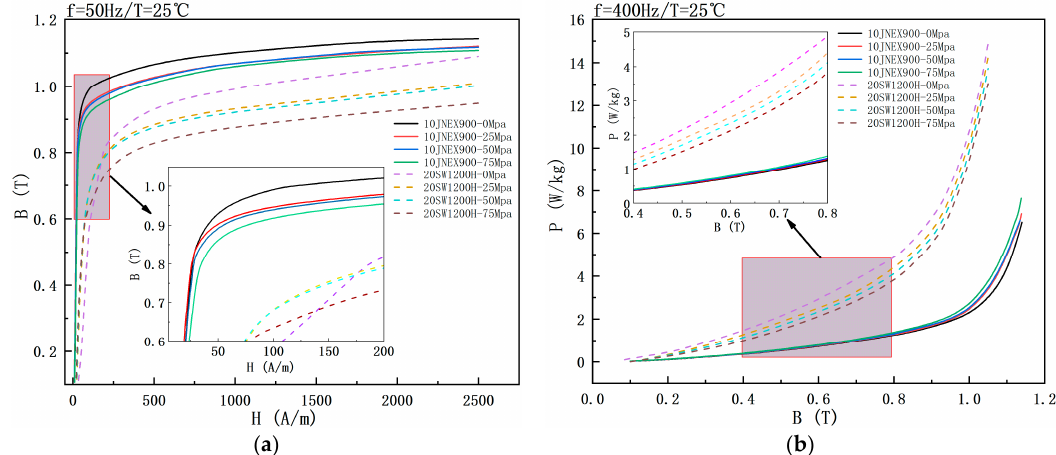
Figure 6. Effect of tensile stress on magnetic properties of two silicon steels at 25 °C. ( a ) B-H curve. ( b ) B-P curve.